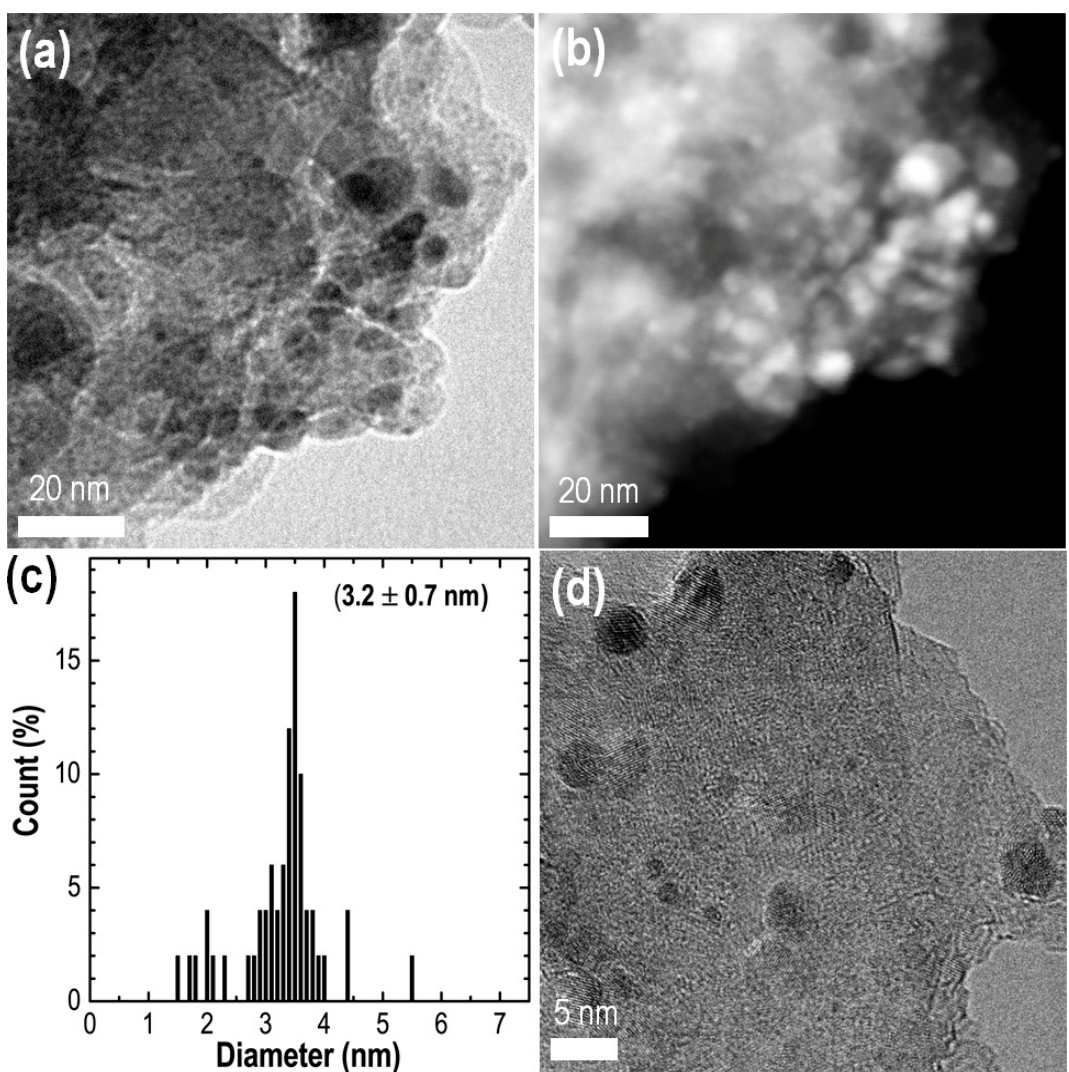
Figure 1. ( a ) TEM image, ( b ) STEM image (dark field), ( c ) histogram plot of particle size distribution and ( d ) HR-TEM image of (1:1) Ag/Pd-HT.